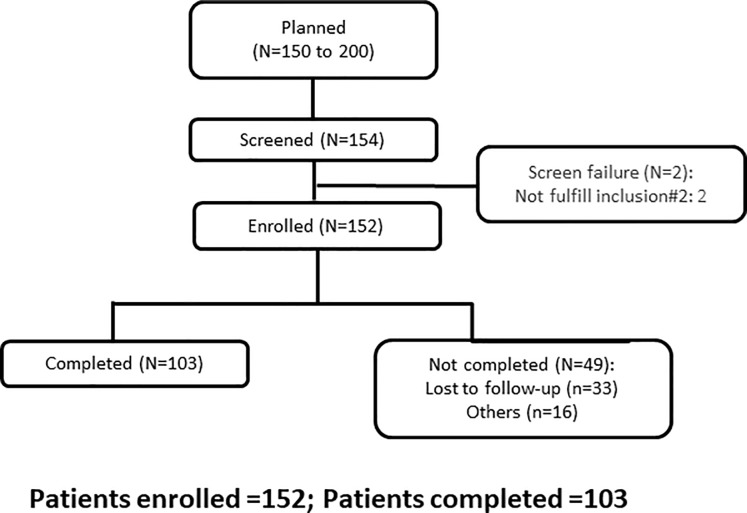
Consort diagram of patient flow.